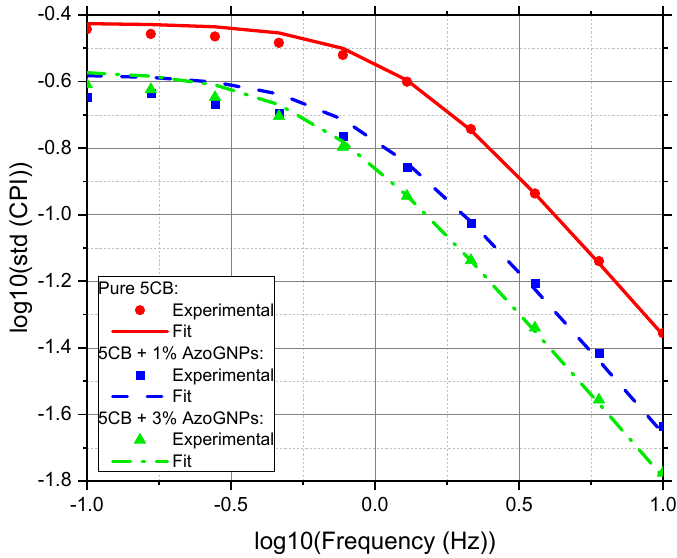
Figure 3. Rotational viscosity measurements of pure and nanoparticle-doped 5CB under light illumination at 642 nm. Experimental data are represented by symbols, and the OMPA fits are shown by solid lines.